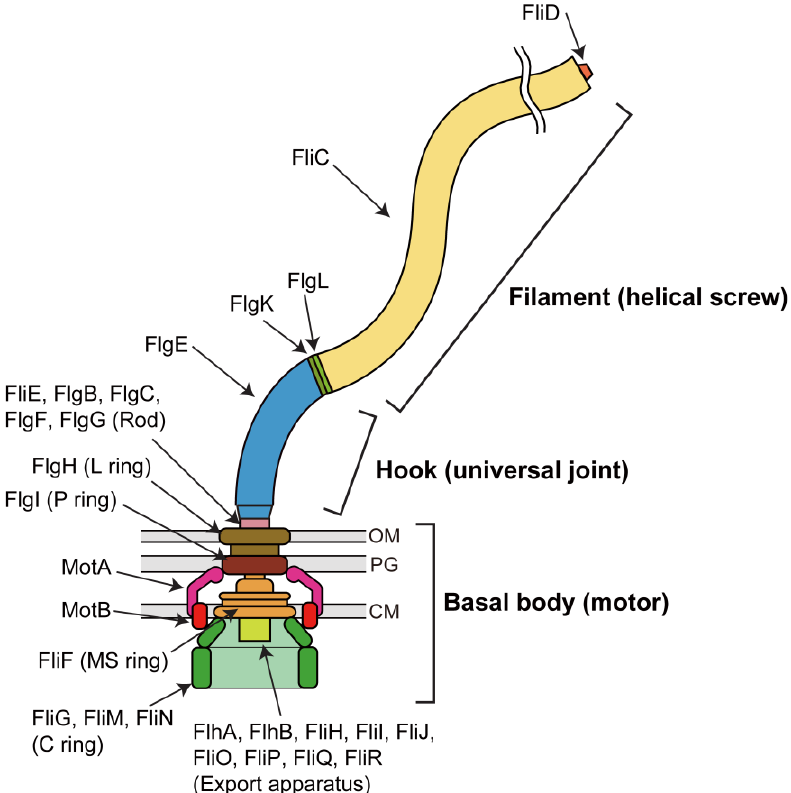
Figure 1. Schematic diagram of the bacterial flagellum. The flagellum is a locomotive organelle for bacterial propulsion. The flagellum consists of the basal body, which acts as a reversible rotary motor, the hook, which functions as a universal joint and the filament, which works as a helical screw. OM, outer membrane; PG, peptidoglycan layer; CM, cytoplasmic membrane.